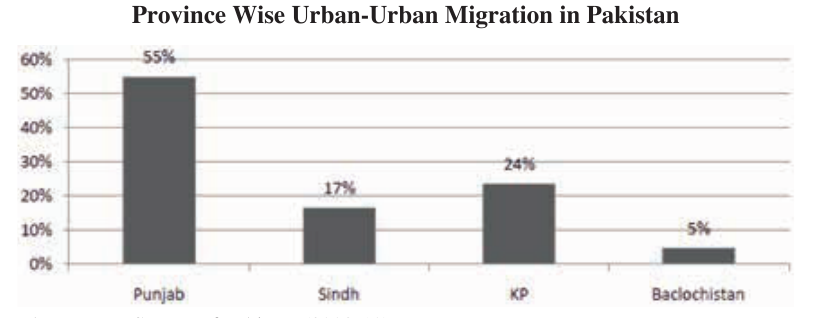
Figure-7 Province Wise Urban-Urban Migration in